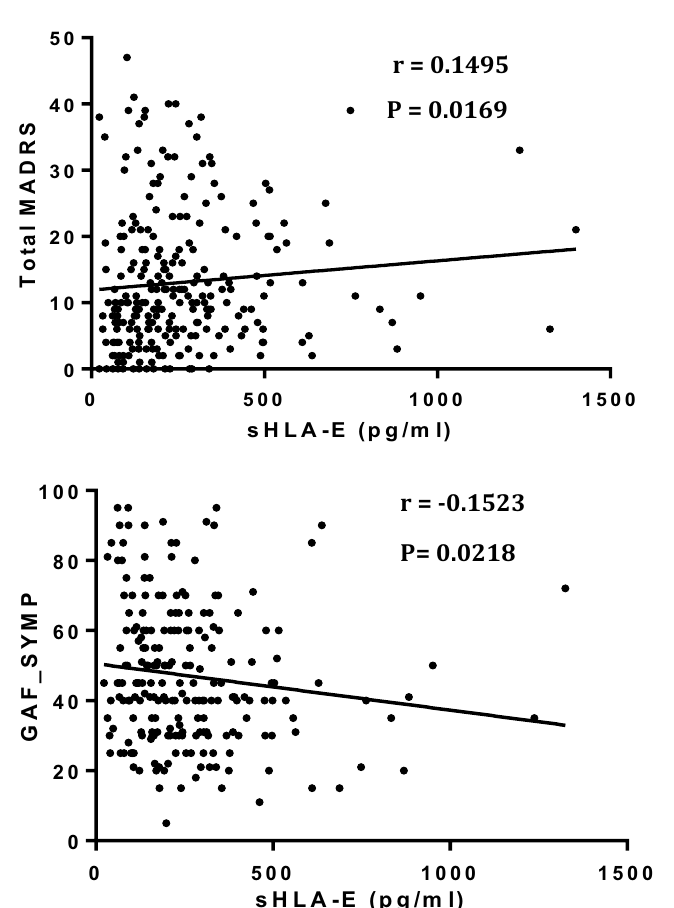
Figure 2. Relationship between circulating levels of sHLA-E, depressive scores measured by MADRS and functioning measured by GAF scores ( p = 0.017 and p = 0.022